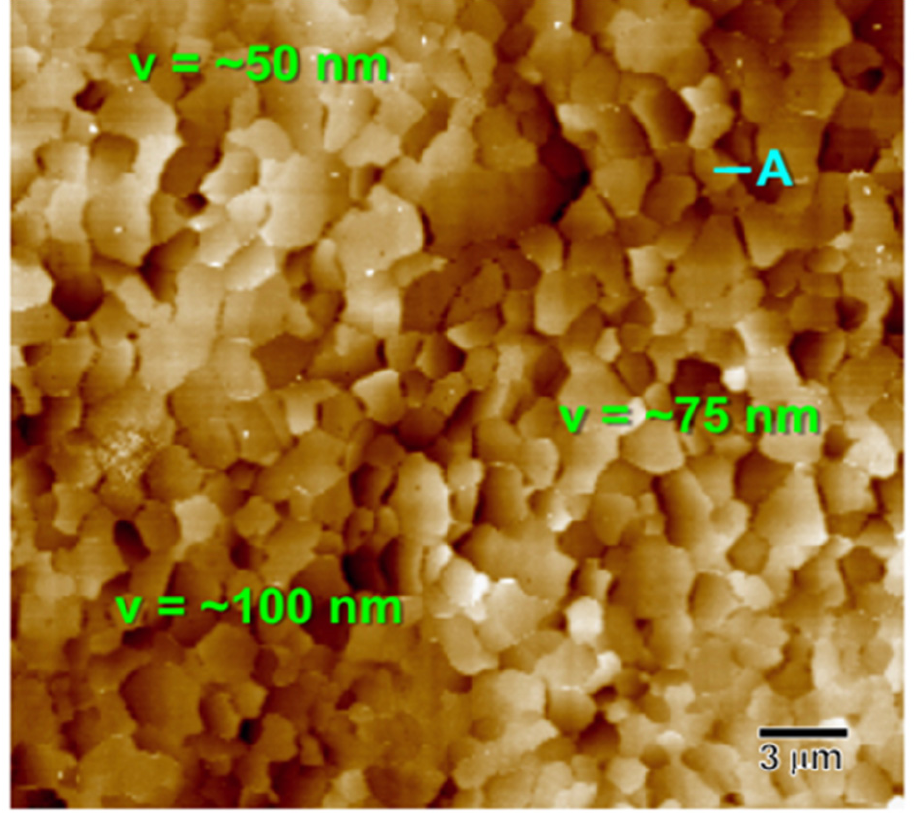
Figure 2. AFM topology of ZK60 Mg alloy under strain rate 0.01 and strain of 0.2 under temperature 250 °C showing GBS phenomenon [17].